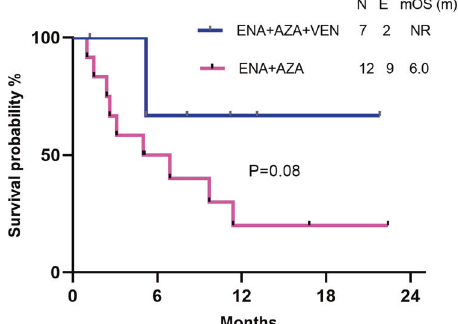
Fig. 3 Kaplan – Meier plot showing overall survival (OS) by veneto- clax status in R/R cohort. N number, E events,mOS (m) median overall survival in months.